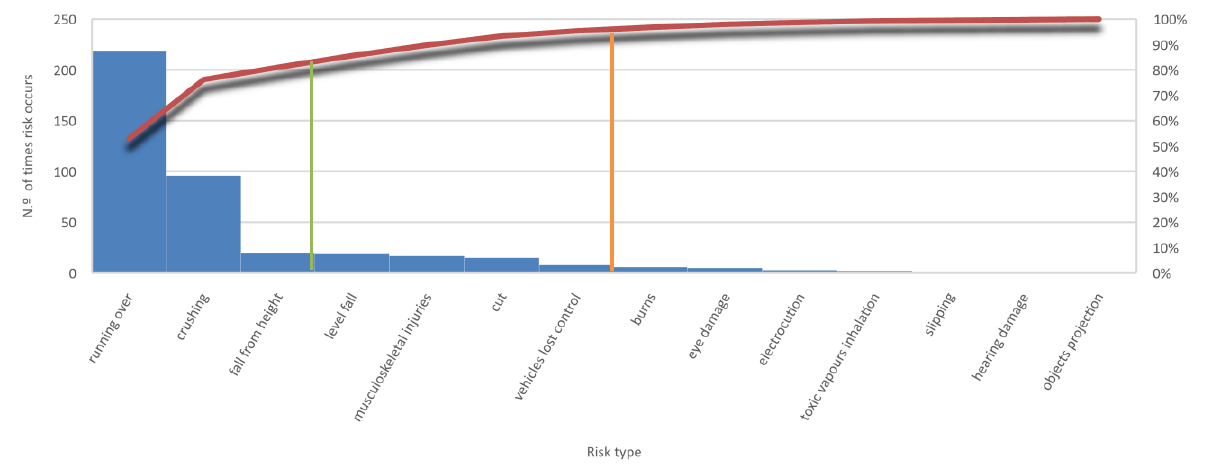
Figure 4. Pareto’s distribution of